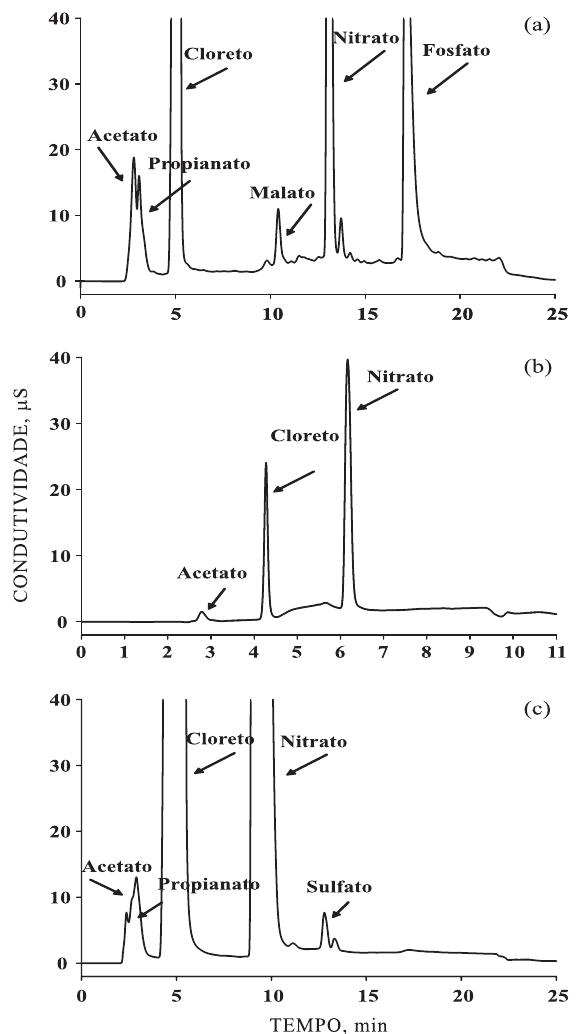
Figura 4. Cromatogramas indicando a presença de ácidos orgânicos e ânions inorgânicos na cama de maravalha (a), lixiviado do tratamento testemunha do solo argiloso, sem aplicação de cama (b) e no lixiviado do solo argiloso tratado com 160 t ha -1 de cama de aviário de maravalha, base material seco